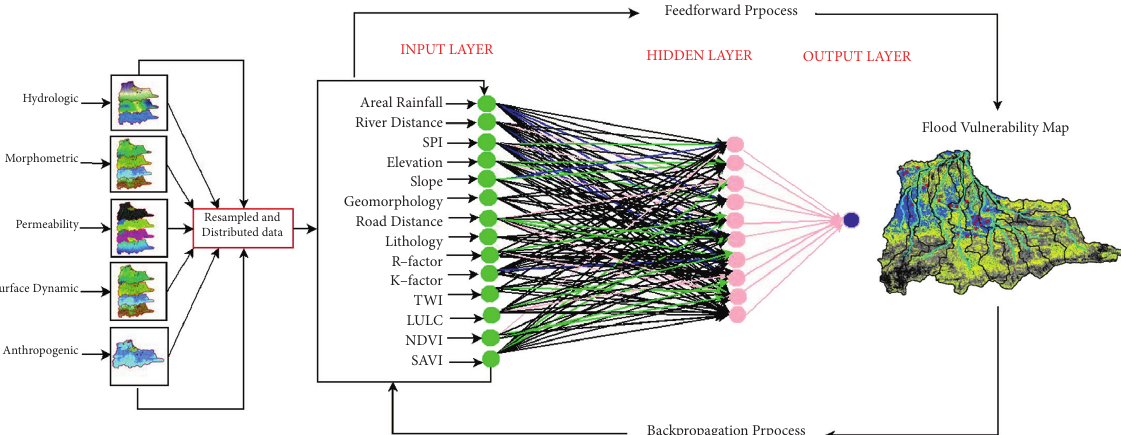
Figure 4: ANN in geospatial analysis for flood vulnerability assessment.